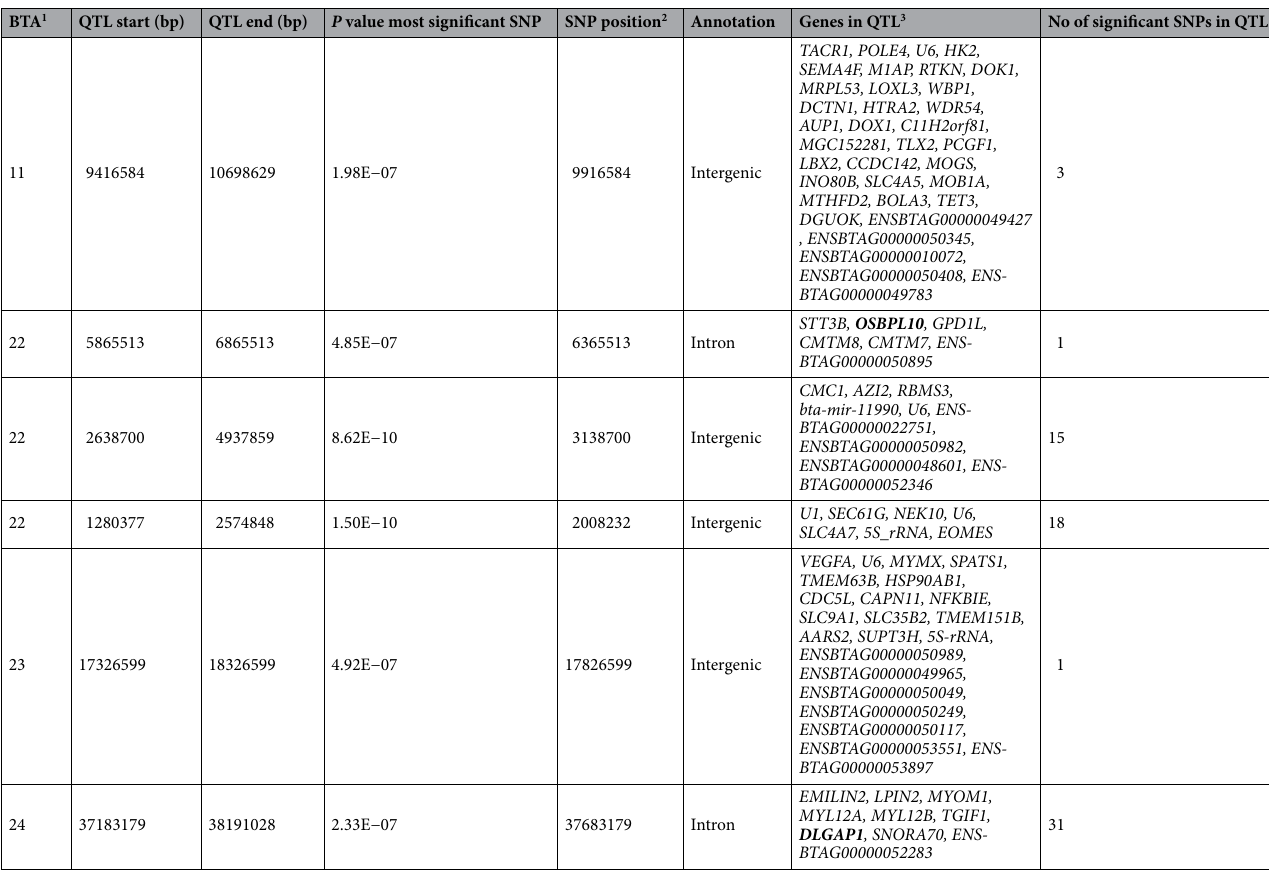
Table 2. QTLs surpassing the significance threshold (P < 5 × 10 −7 ) for evidence of an association with the multifocal lesions. 1 QTL location, 2 SNP location in the genome assembly, 3 Positional candidate genes are defined as genes that are located within 50 kb on either side of the identified